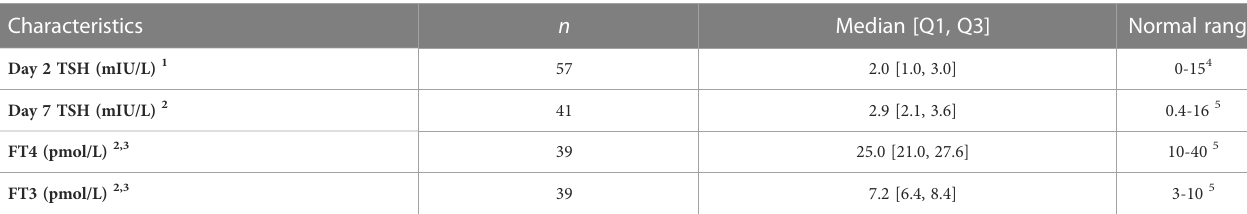
FT3, free triiodothyronine; FT4, free thyroxine (tetraiodothyronine); Q1, quartile 1 (25 th percentile); Q3, quartile 3 (75 th percentile); and TSH, thyroid-stimulating hormone. 1 Whole-blood TSH from Guthrie cards performed as part of the New Zealand National Screening Programme. 2 Serum values from thyroid function tests were performed within the SELFI Study. 3 FT4 and FT3 results were not available for two babies with inadequate samples to perform these tests. 4 Heather et al. Evaluation of the revised New Zealand national newborn screening protocol for congenital hypothyroidism. Clin Endocrinol 2017;86:431 – 7. 5 Reference range for TFT assays at Labtests, Auckland, where the tests were performed. Serum TSH, FT4, and FT3 were measured with an electrochemiluminescence immunoassay using a Siemens ADVIA Centaur XP